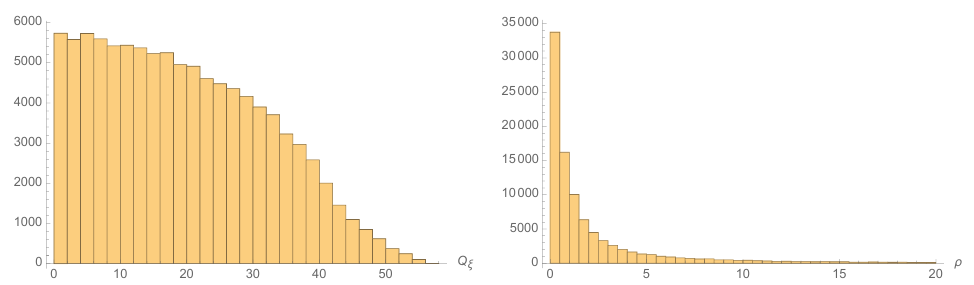
Figure 5 . Left: distribution of the alignment Q ξ defined in (2.17). We allowed a random distribu- tion of integers Q Ij , I = 1 , 2 , 3 , j = 1 , 2 , from − 40 to 40 . For sufficient enhancement of the effective decay constant, we need a high degree of alignment, or small Q ξ . Right: distribution of ρ defined in (4.42), which should be greater than the ratio of decay constants (4.38). We see that ρ ∼ 1 is strongly